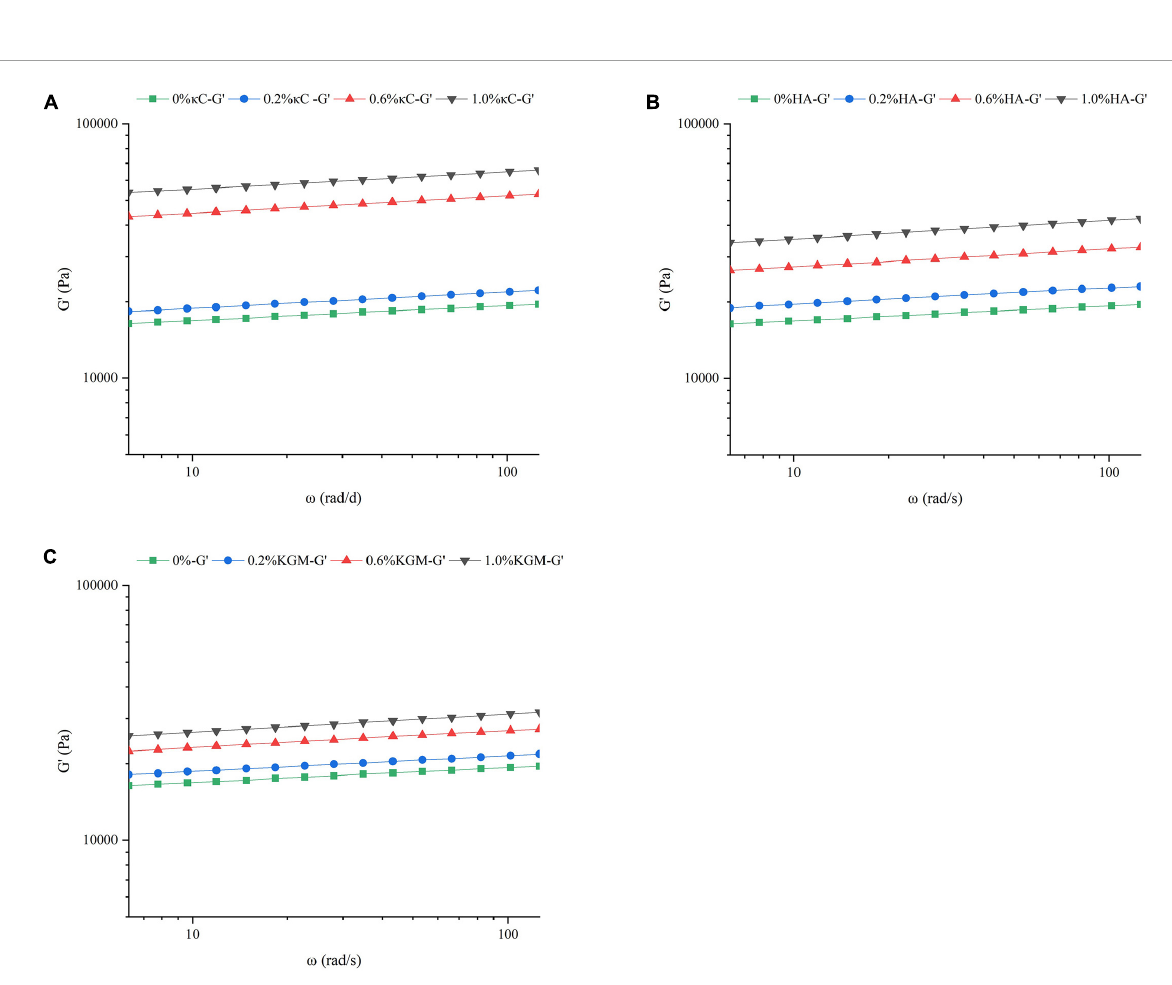
FIGURE3 Frequency sweep of the storage modulus (G’) of emulsion gels containing different polysaccharides ( A , κ C, B , HA, and C , KGM) at 25 ◦ C. κ C, κ -carrageenan; HA, high-acyl gellan; KGM, konjac